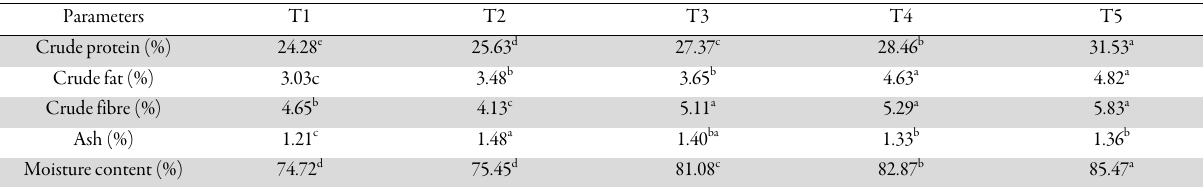
Table 4 . Proximate composition of the fish